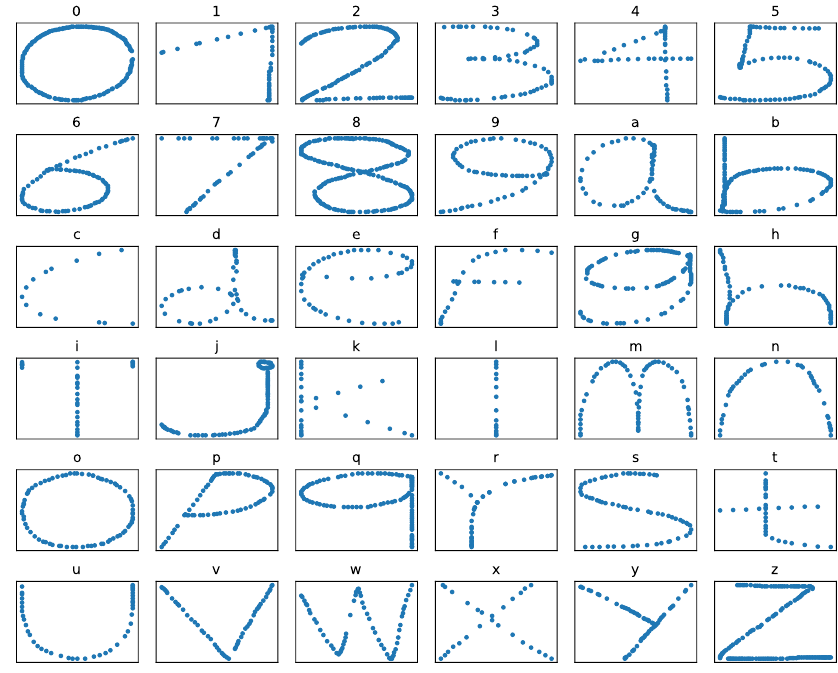
Figure 4. Example of the representative characters written on the